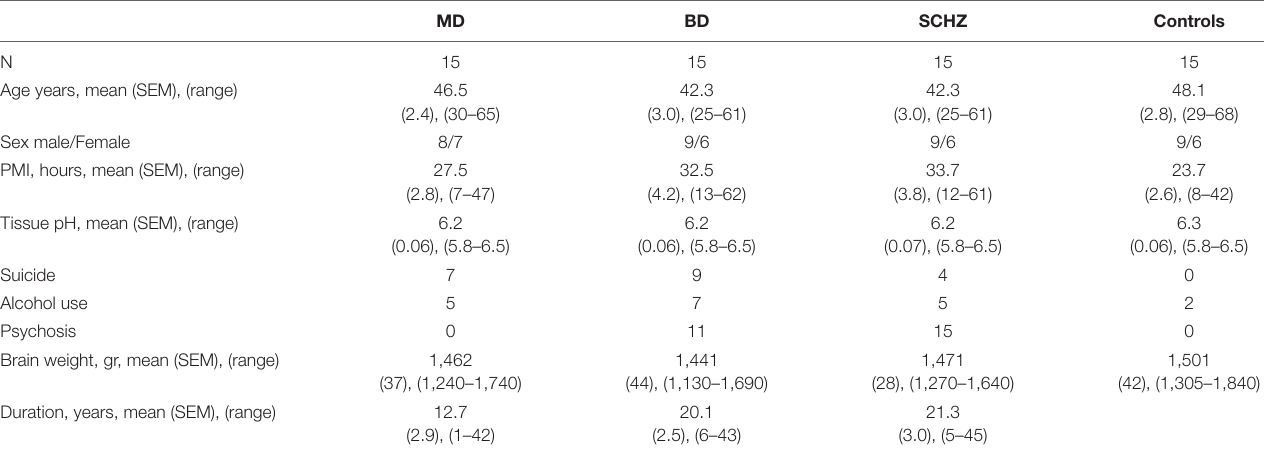
TABLE 1 | Clinical and demographical data of the Stanley Neuropathology